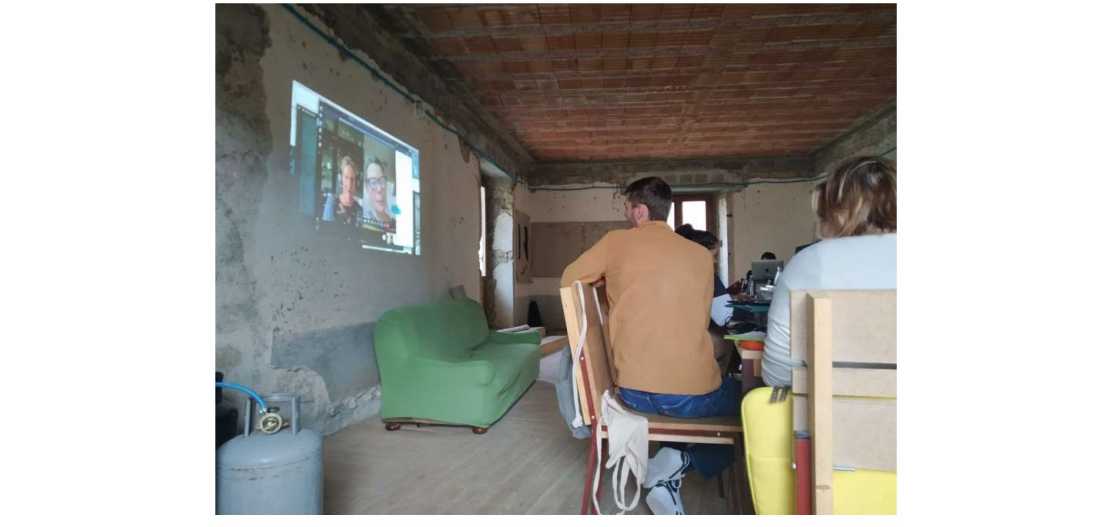
Figure 5. Online teaching in the Casa with tutors from London (Source: photograph by Francesca